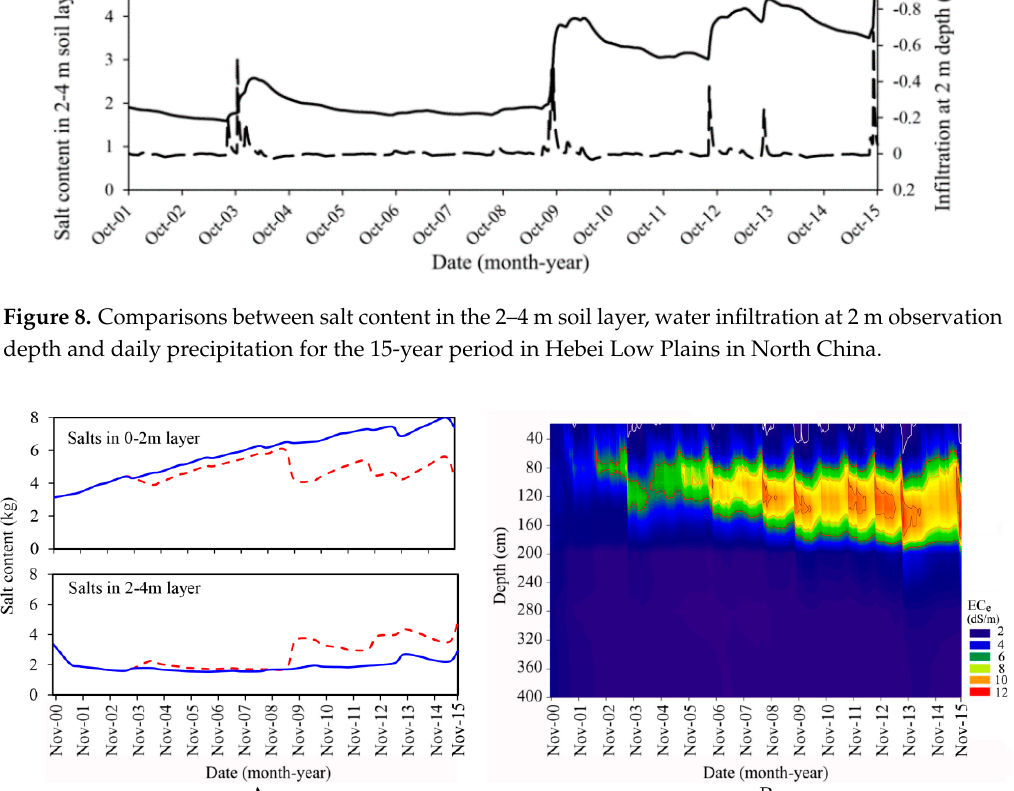
Figure 8. Comparisons between salt content in the 2–4 m soil layer, water infiltration at 2 m observation depth and daily precipitation for the 15-year period in Hebei Low Plains in North China.